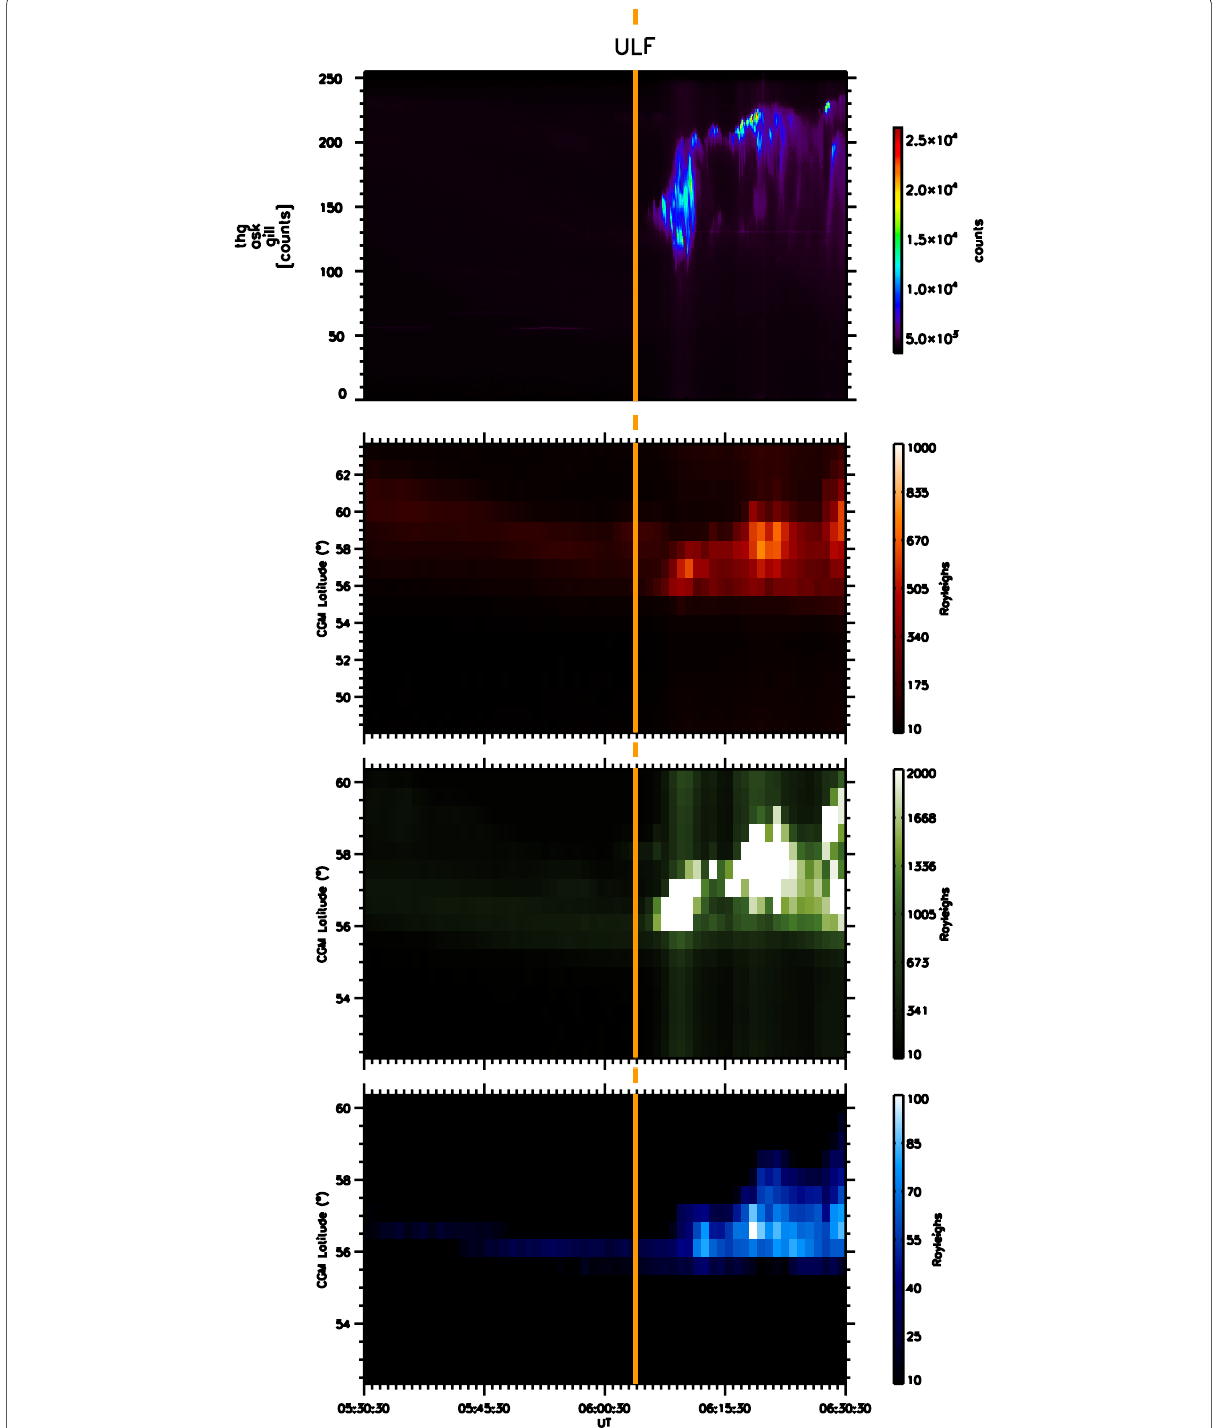
Fig. 2 North–south slices (keograms) from the GILL THEMIS ASI and GILL NORSTAR MSP from 05:30:30 to 06:30:30 UT. From top to bottom, the figure shows data from the white-light GILL ASI, together with the 6300 A (red), 5577 A (green) and 4861 A (blue) emission lines from the GILL NOR- STAR MSP. The orange vertical line denotes the first observation of ULF waves during this interval, at 06:04:20 UT, discussed later in the